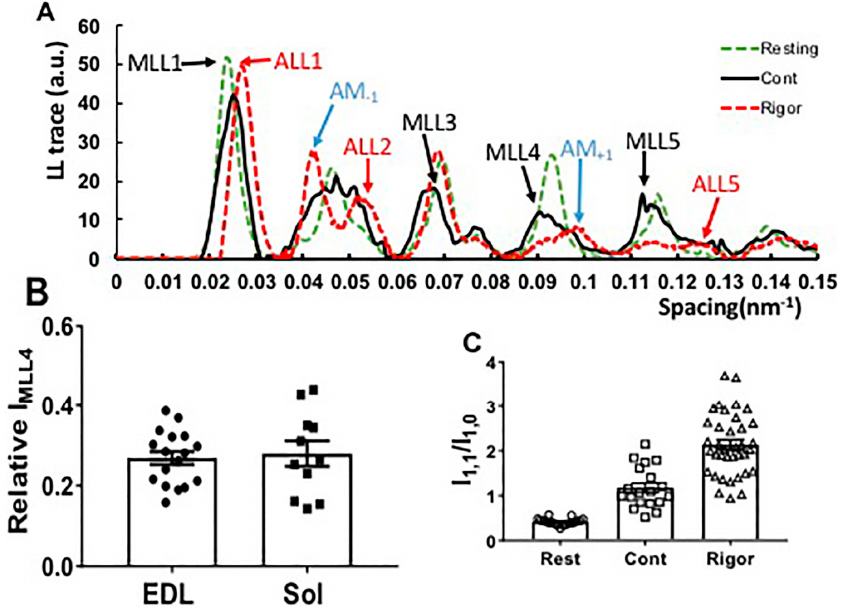
Figure 3. Residual myosin layer line (MLL) intensity in X ‐ ray patterns from contracting mouse muscle. ( A ) The layer line intensity traces from resting (green arrows), contracting (black arrows) and rigor patterns (red arrows) along the meridian integrated over a radial spacing range from 0.03 nm − 1 to 0.077 nm − 1 . Both myosin (MLL) and actin (ALL) layer lines were present in contracting patterns, while all myosin layer lines were replaced by actin ‐ or actomyosin ‐ based layer lines in rigor patterns. ( B ) MLL4 remained at about 30% of its resting value in both EDL (0.27 ± 0.02, n = 17) and soleus muscle (0.28 ± 0.1, n = 11) during the plateau region of tetanic contraction. ( C ) Equatorial intensity ratio in resting (Rest), contracting (Cont) and rigor (Rigor) muscle.